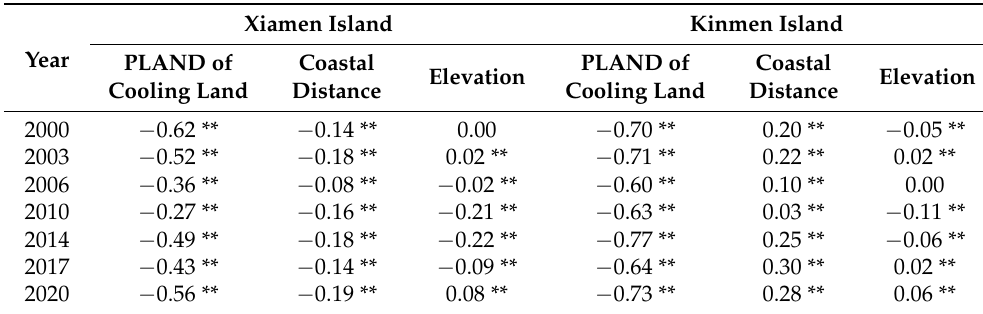
Table 5. Partial correlation coefficient with Spearman’s rho ( pr s ) between LST and other variables. Xiamen Year